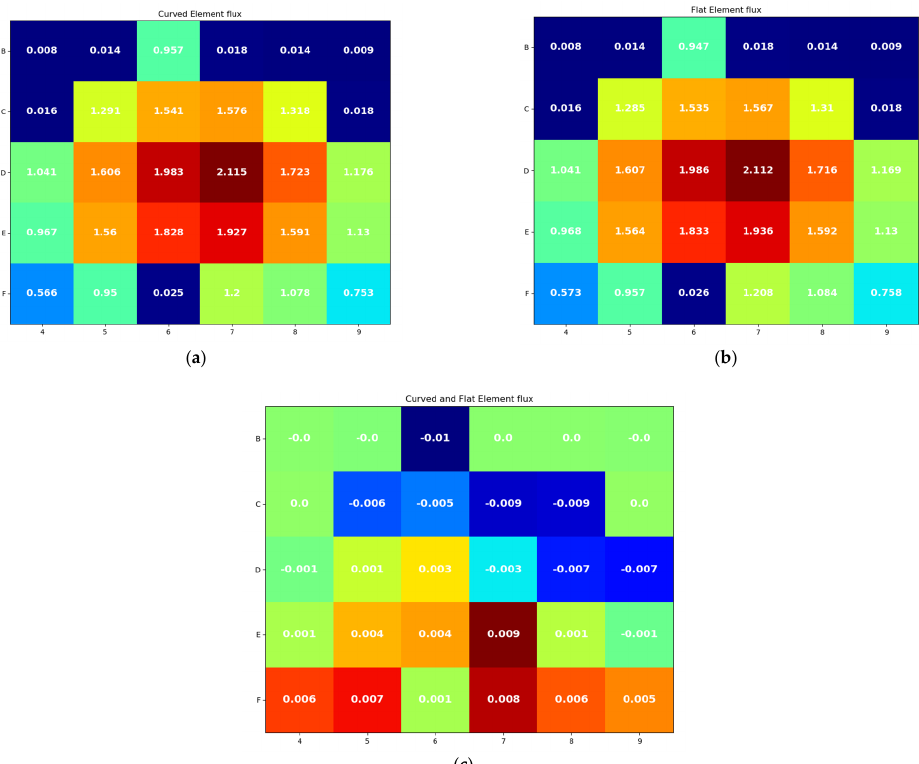
Processes 2023 , 11 , 637 Figure 12. Radial fl ux of ( a ) curved fuel, ( b ) fl at fuel, and ( c ) the di ff erence between the fl uxes. Figure 12. Radial flux of ( a ) curved fuel, ( b ) flat fuel, and ( c ) the difference between the fluxes.